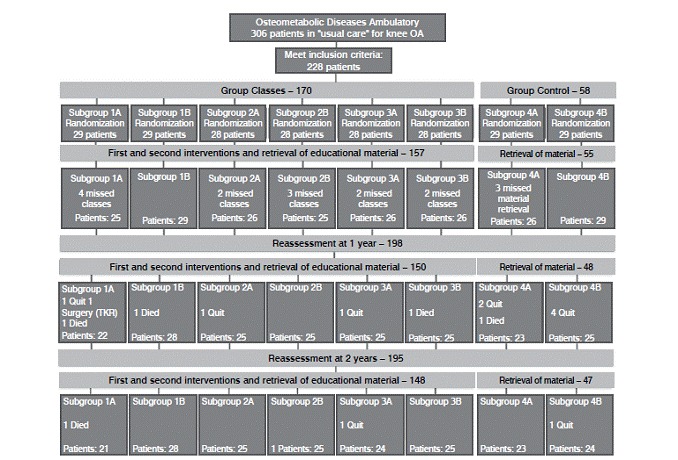
Flow of participants through the trial.